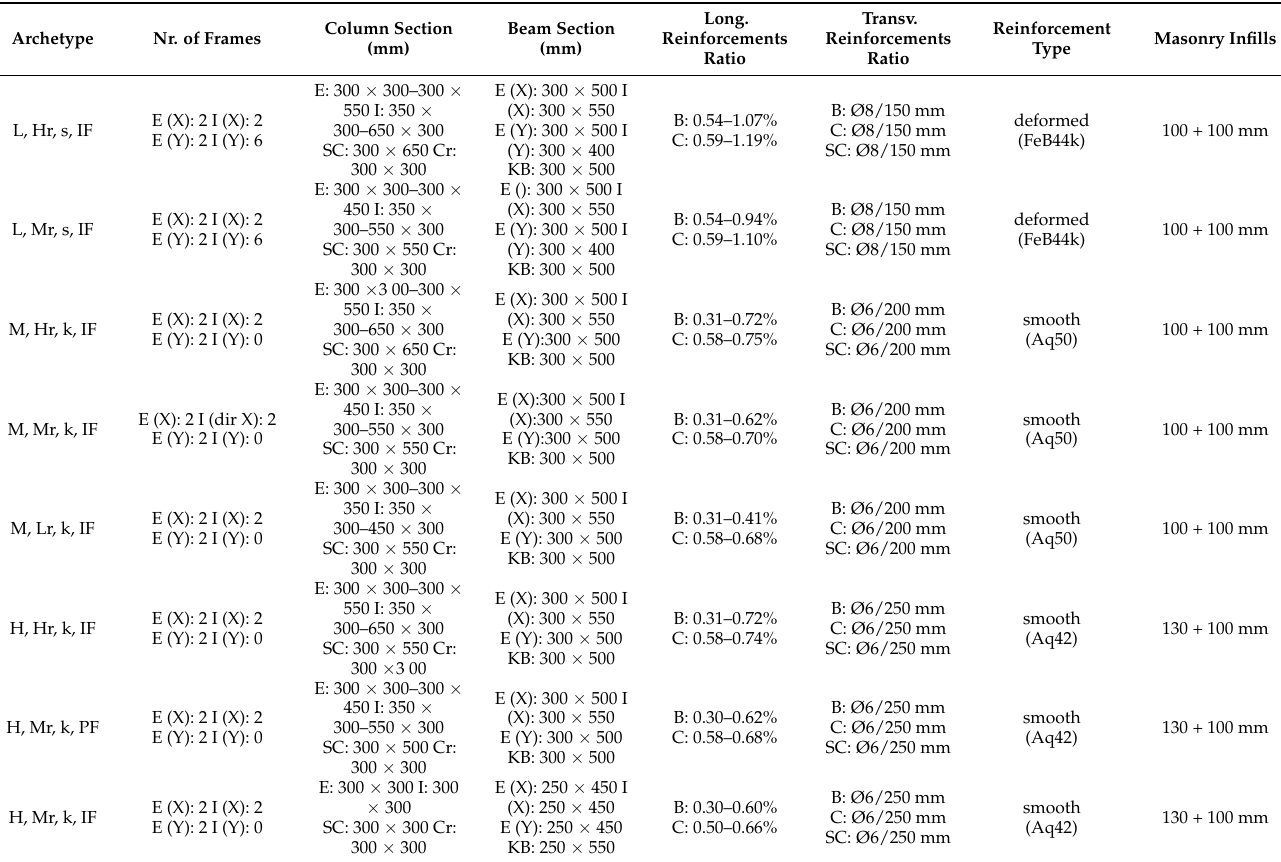
Figure 3. Building layout: structural plan view. Table 5. Main geometrical characteristics and steel reinforcement details of the selected archetype